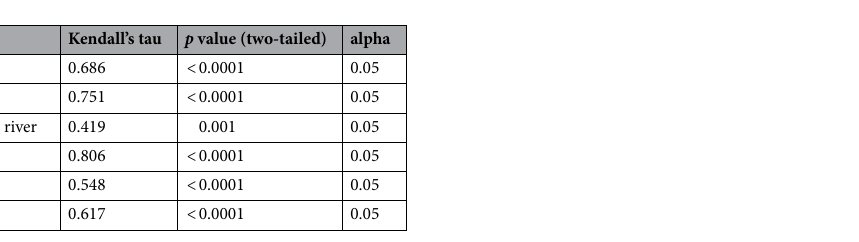
Table 1. Mann–Kendall (M–K) trend test results of surface water area in the Tarim River Basin and its tributary rivers and terminal lake.